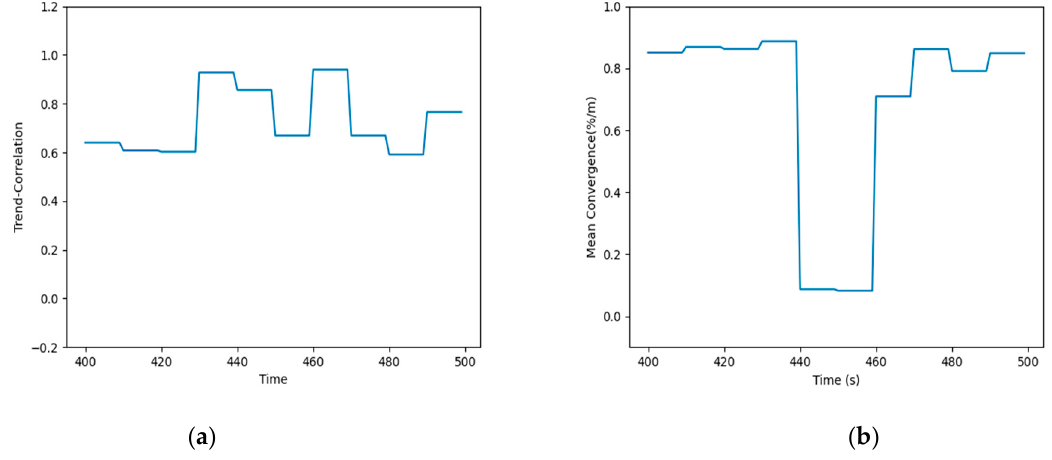
Figure 12. The credibility of the data source. ( a ) The trend correlation; ( b ) The mean aggregation.